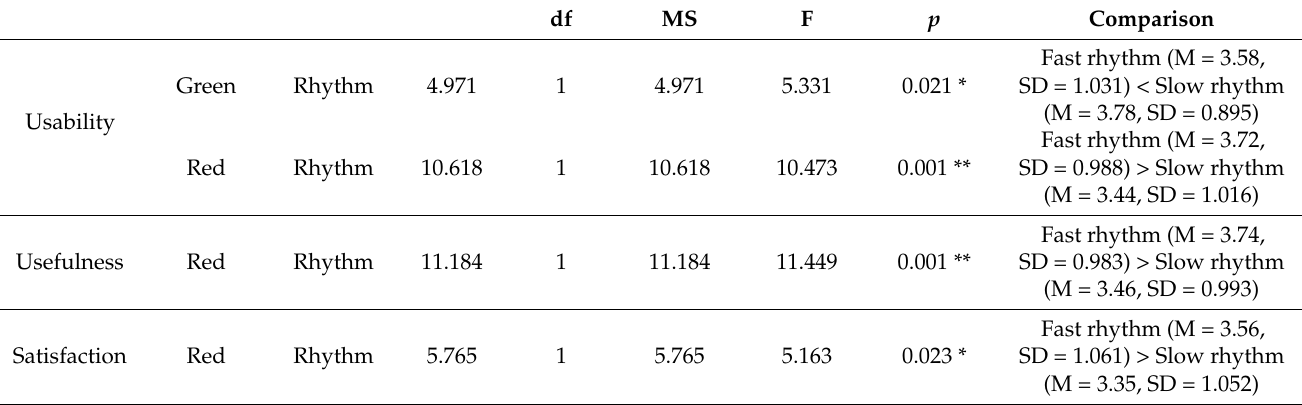
Table 14. Verification and analysis results of simple main effect of subjective cognition in waiting-to- restart scenario. df F p